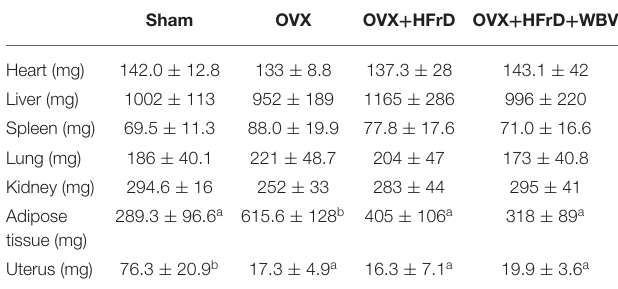
TABLE 3 | The body composition with OVX, HFrD, and WBV